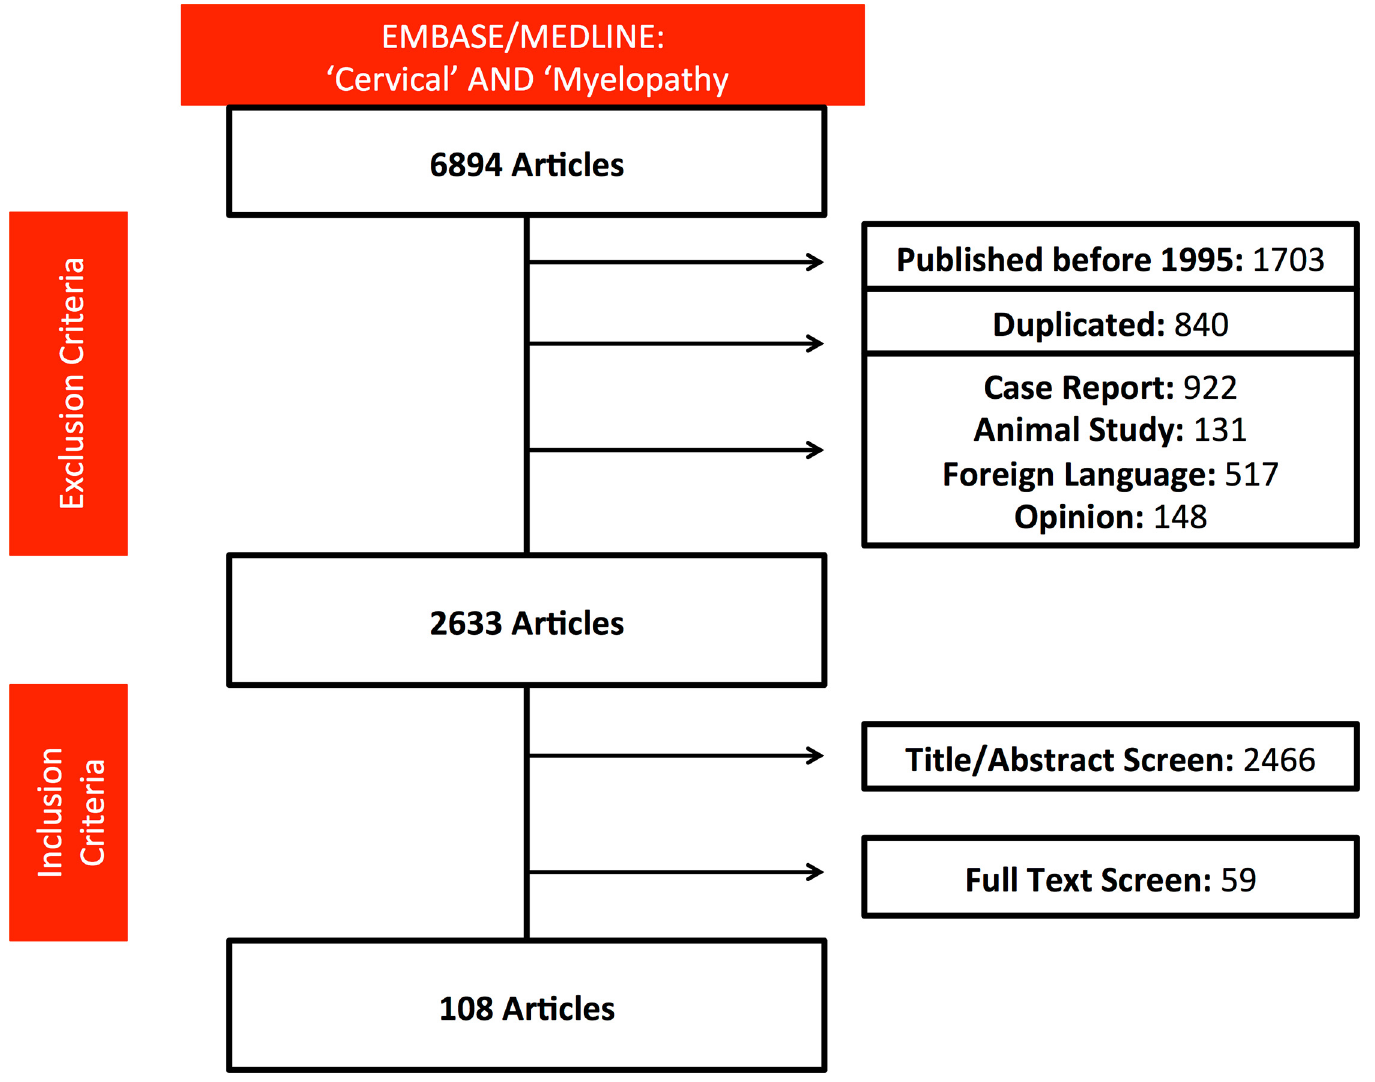
Fig 1. PRISMA flow diagram of the search